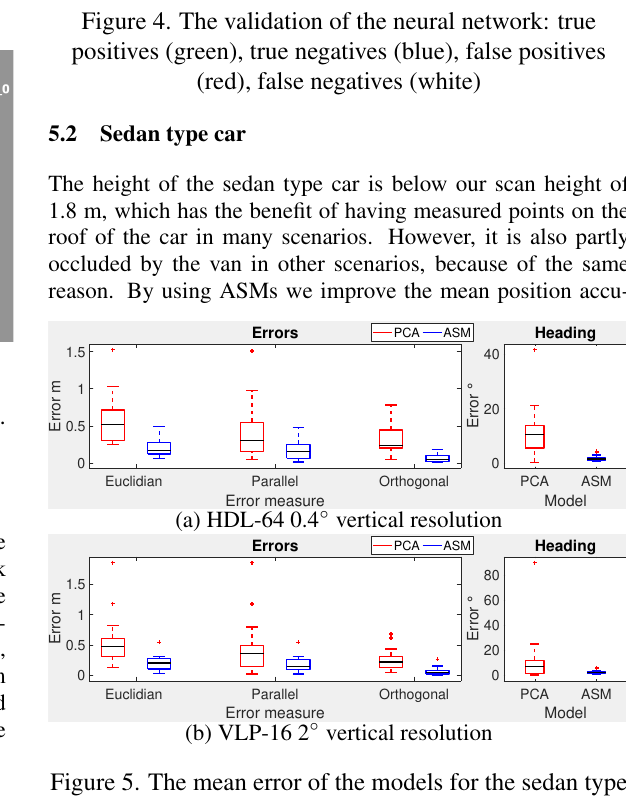
Figure 3 (red points). The ASM position error orthogonal to